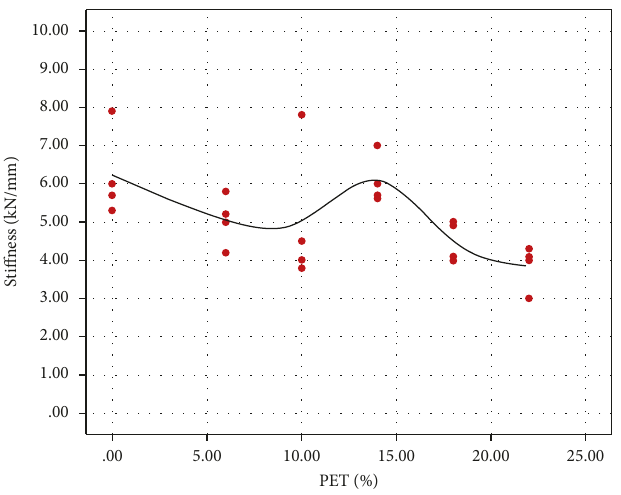
Figure 6: Marshall stiffness modulus for different percentages of PET at 60 ° .